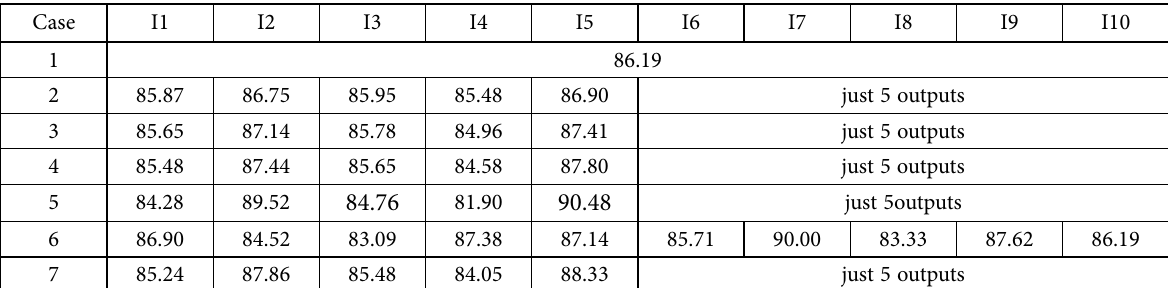
Table 2. Summary of CSI values obtained for each